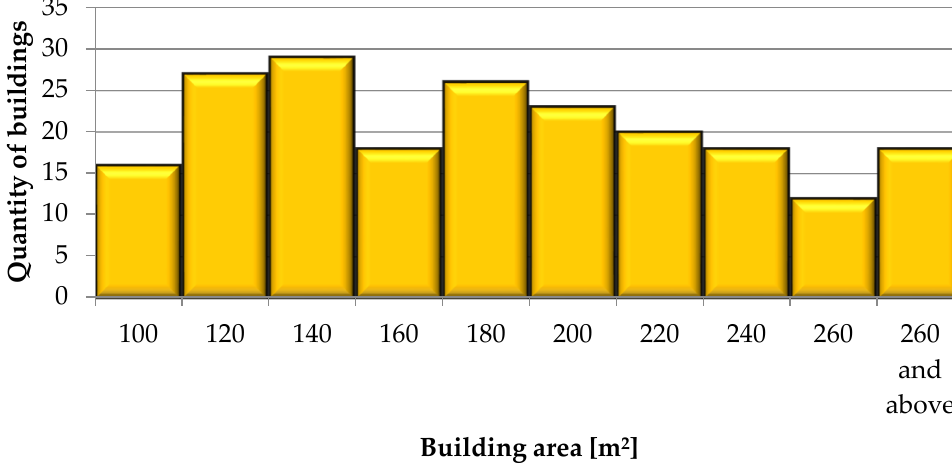
Figure 9. Distribution of data for the variable relating to the building area [m 2 ].